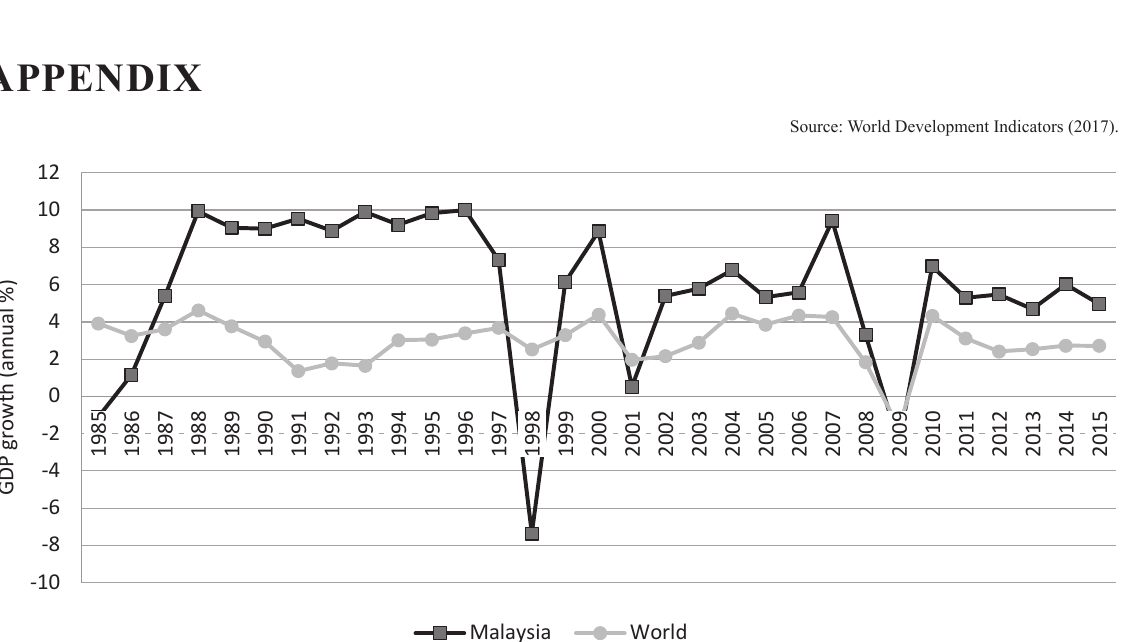
Figure 1. Trend in GDP growth rate (annual %) in the period 1985–2015